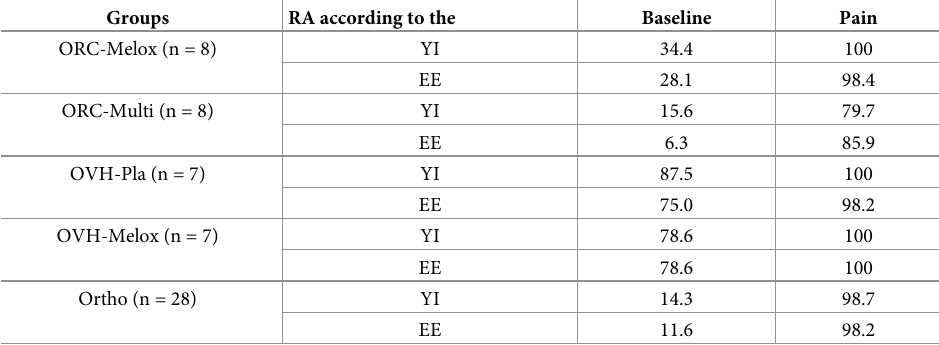
Table 13. Percentage of rabbits in each group would receive rescue analgesia in baseline and pain time points, according to the Evaluator Experience (EE) and the Youden Index (YI) of the RPBS.